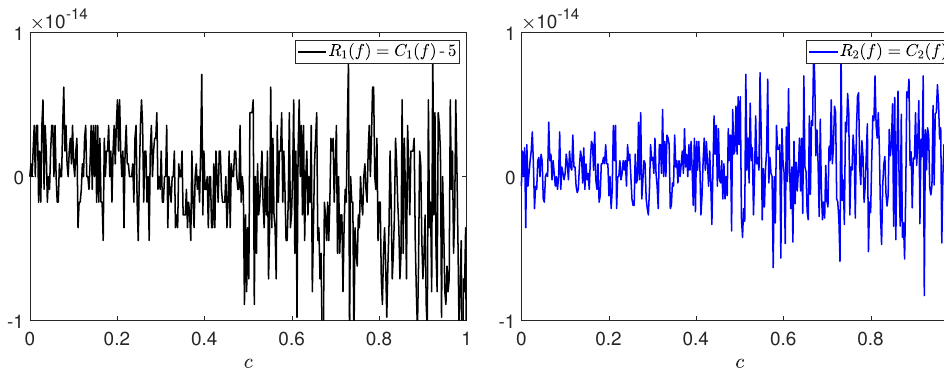
Figure 3. Residual of the constraints C 1 ( left plot) and C 2 ( right plot) when applied to the functional f ( x , g ( x )) given by